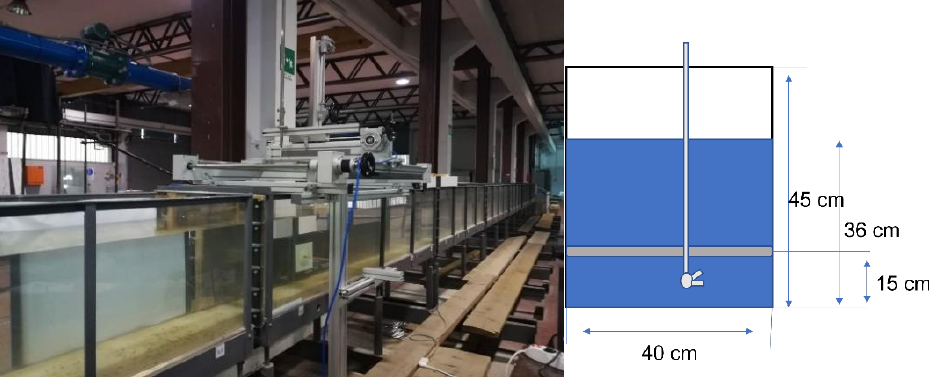
Figure 1. Water channel for experiments ( left ) and its cross-section ( right ).